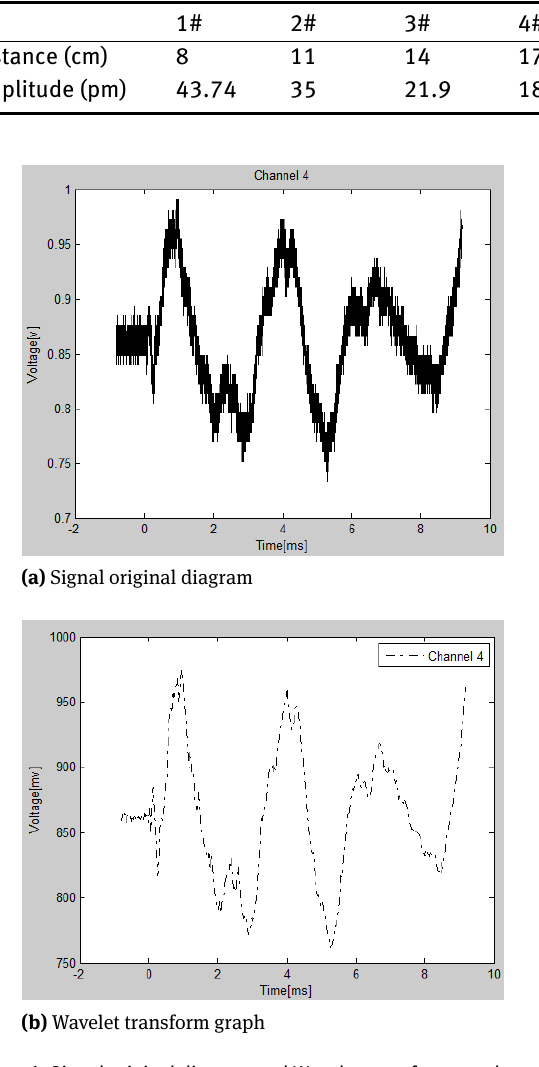
Figure 6: Signal original diagram and Wavelet transform graph